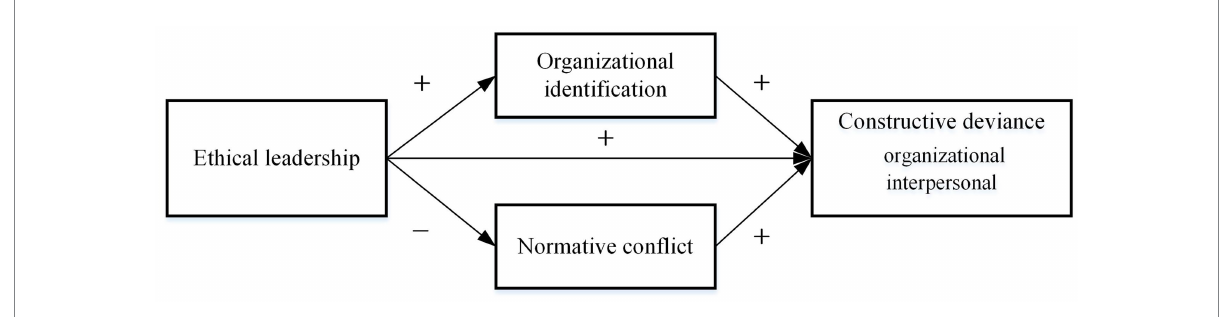
FIGURE 1 Theoretical